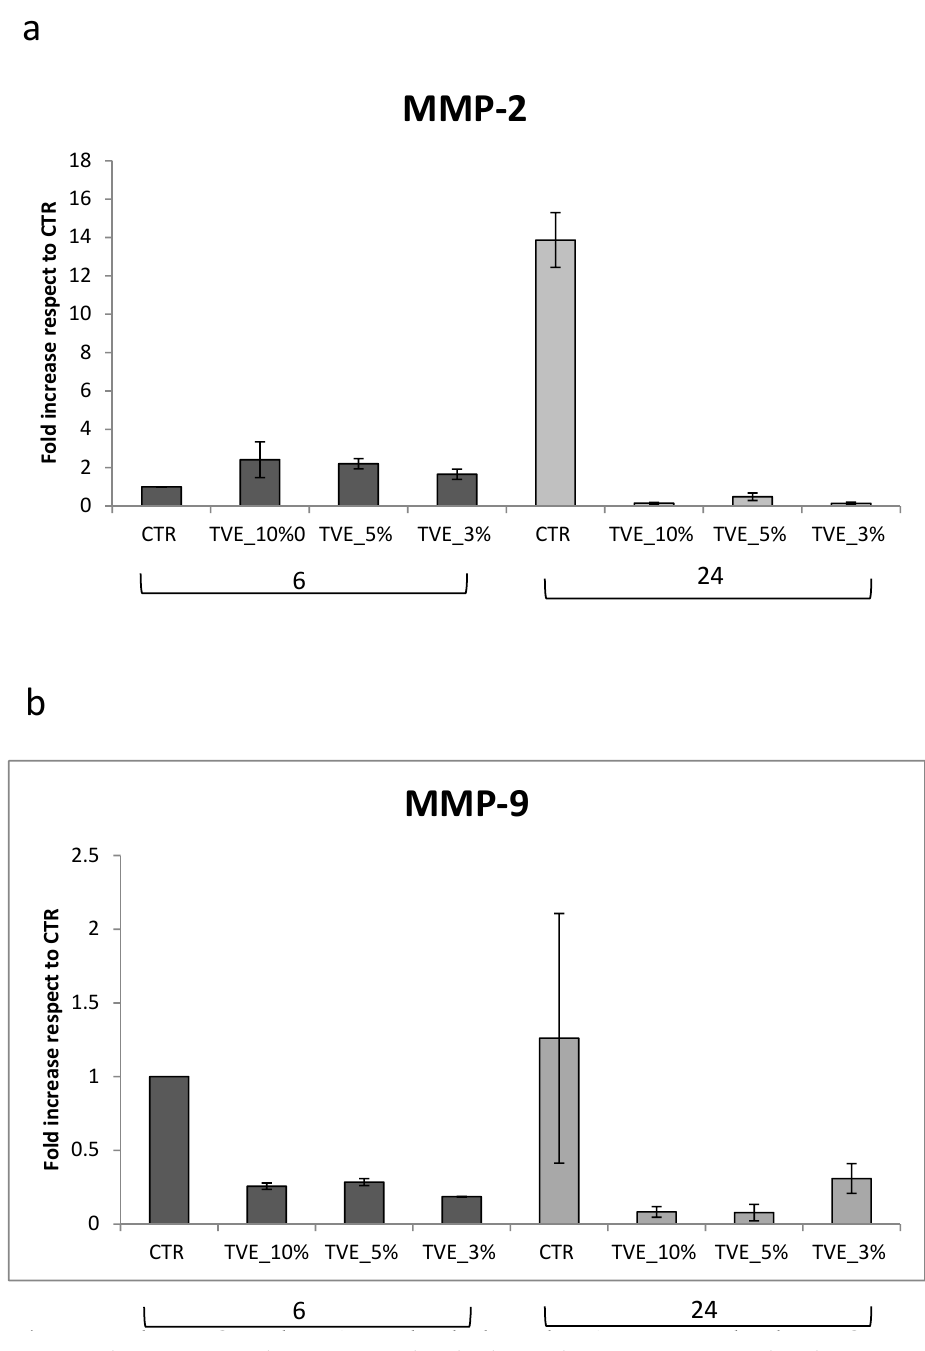
Figure 3. Real-time PCR analysis. At 6 and 24 h, the total RNA was extracted and qRT-PCR was performed to determine the gene expression of MMP-2 ( a ) and MMP-9 ( b ). Data are presented as mean ±